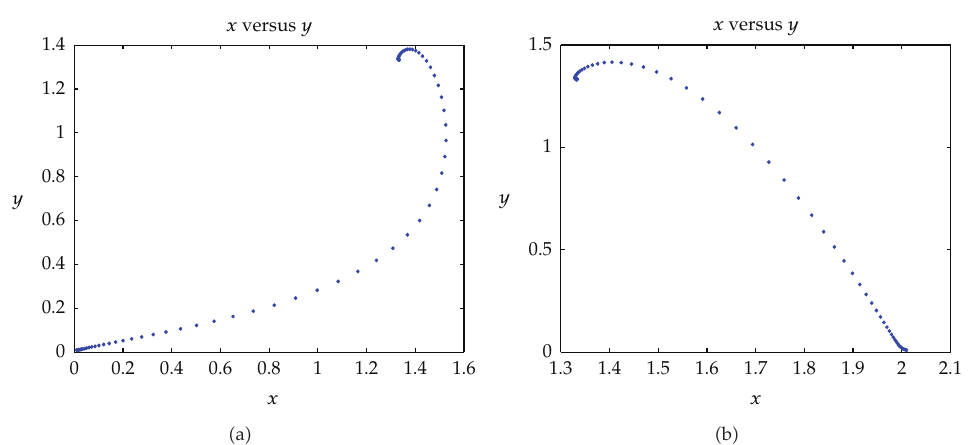
Figure 2: W -asymptotical stability of system (cid:2) 2.7 (cid:5) with di ff erent initial values. (cid:2) a (cid:5) and (cid:2) b (cid:5) show phase